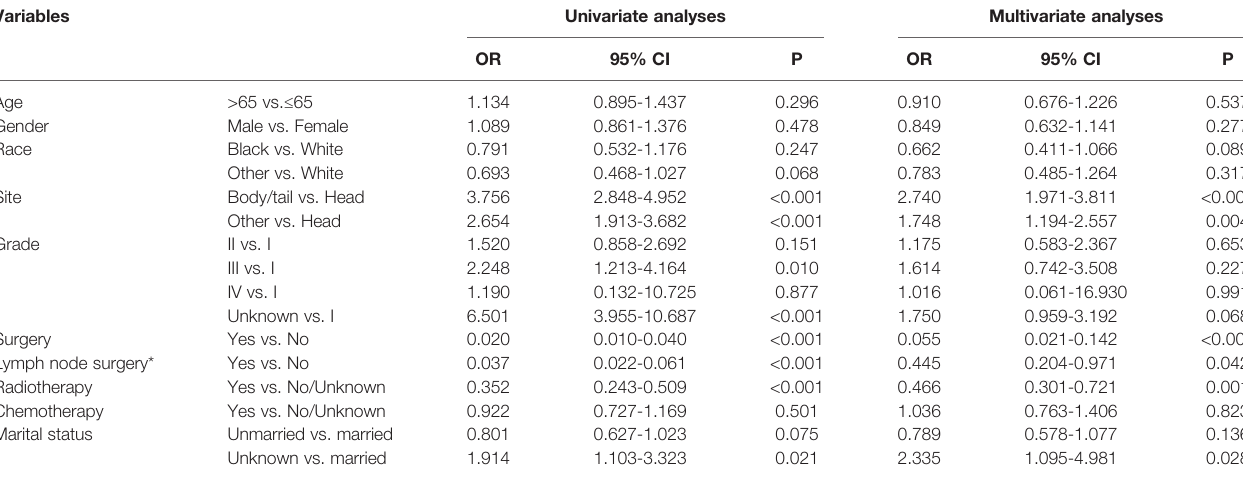
TABLE 4 | Univariate and multivariate logistic regression analyses of baseline factors associated with distant metastases in patients withIPMN withassociatedinvasive carcinoma. Variables